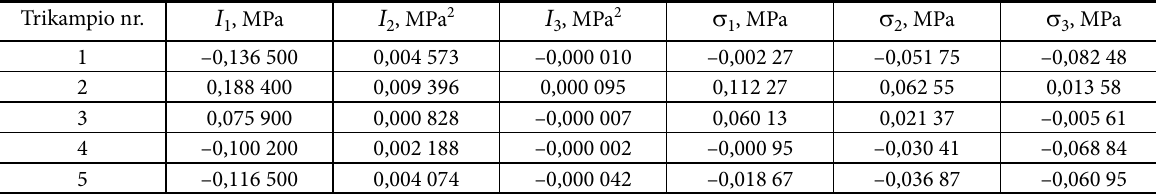
Table 2. Invariants of stresses tensor and changes of principal stresses Trikampio